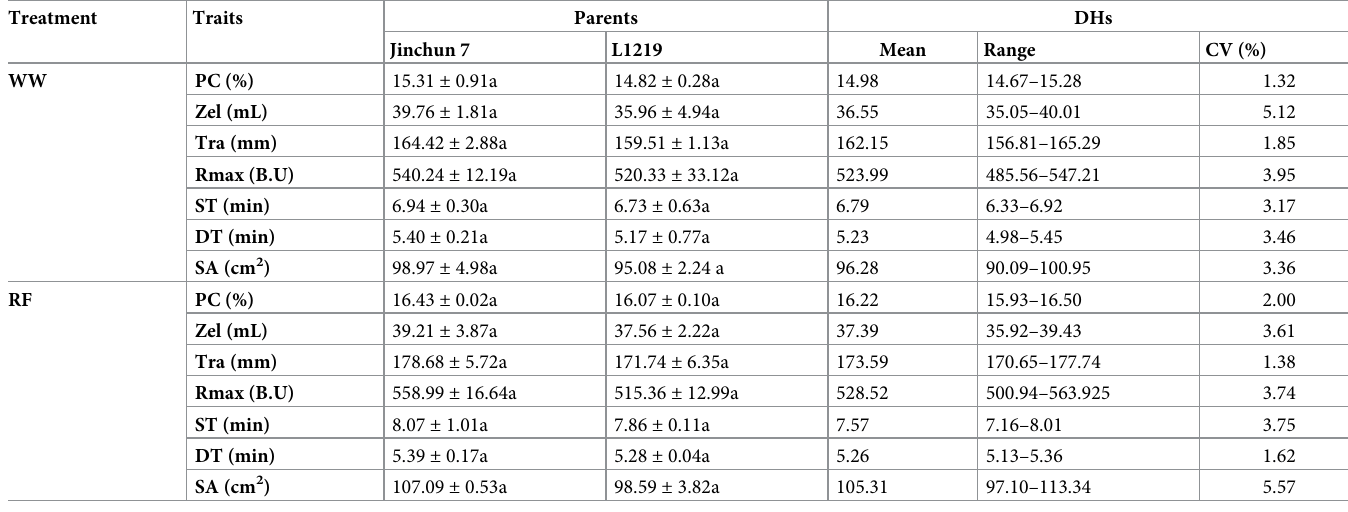
Table 2. Variation in quality traits of DHs in different water regimes.